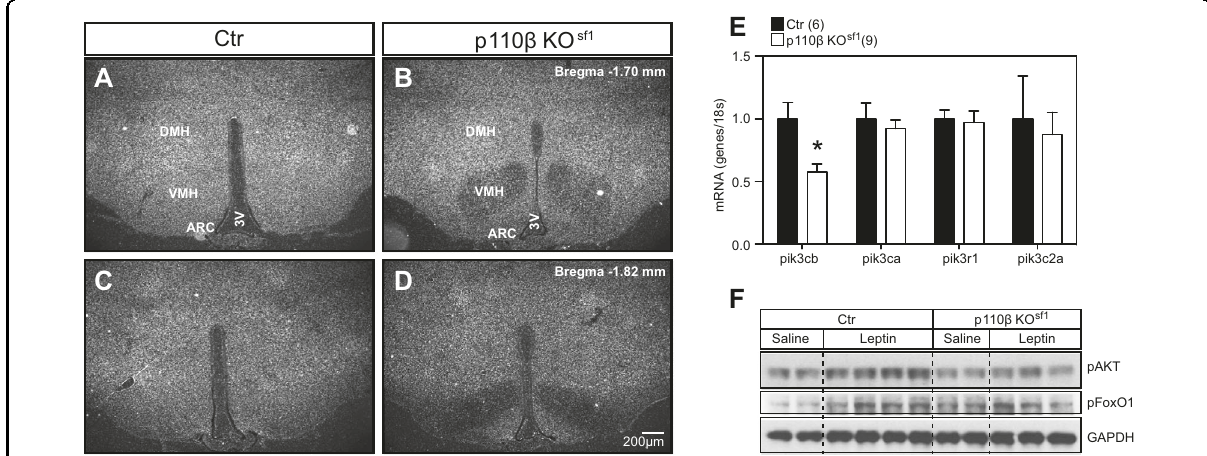
Fig. 1 Deletion of p110 β is restricted to SF-1 neurons of the VMH. Expression of p110 β detected by RNA in situ hybridization in the anterior VMH of a control and b p110 β KO sf1 mice, and the posterior VMH of c control and d p110 β KO sf1 mice. e mRNA expression of p110 β , p110 α , p85 α , and PI3K- C2 α in the VMH of control and p110 β KO sf1 mice. f The VMH was collected after i.p. administration of leptin (5 mg/kg body weight) and the levels of pAKT and pFoxO1 were measured in control and p110 β KO sf1 mice. The number of mice in each group is indicated in the fi gure. * P < 0.05 by Student ’ s t -test. Data are shown as mean ± SEM. Scale bar = 200 μ m. Abbreviations: 3V, third ventricle; ARC, arcuate nucleus; Ctr, control;